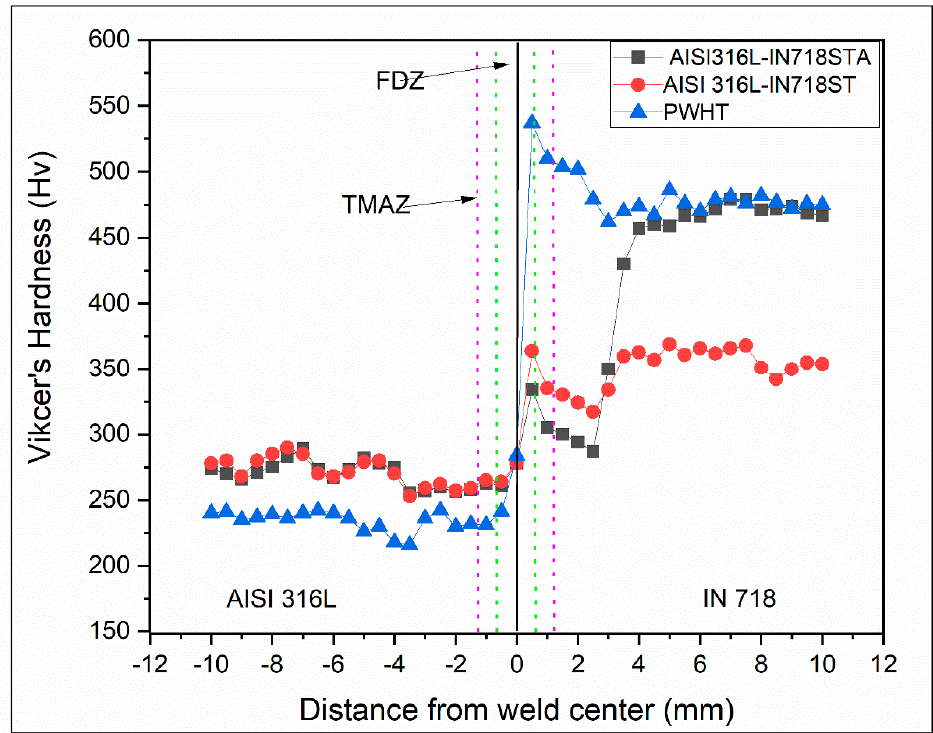
Figure 10. The microhardness distribution across the weld interface of dissimilar friction welds AISI316L-IN718 ST, AISI316L-IN718 STA, and PWHT. The tensile properties of the dissimilar weldments, including AISI 316L/IN 718 ST and AISI 316L/IN 718 STA, in both as-welded and AISI 316L/IN 718 ST PWHT conditions, were evaluated through tensile tests. The corresponding tensile curves are presented in Figure 11. From the stress vs. strain curves, the following points are noted. The AISI 316L/IN 718 ST welds showed a YS and UTS of 634 ± 9 MPa and 728 ± 7 MPa, respectively, while the % El was about 14 ± 1.5%. In contrast, the AISI 316L/IN 718 STA weldment showed YS and UTS of 602 ± 3 MPa and 697 ± 2 MPa, respectively, while the % El was about 17 ± 0.9%. As previously stated, the effect of dynamic recrystallization during the welding process in AISI 316L/IN 718 ST was higher than in AISI 316L/IN 718 STA, resulting in a drop in strength values for the latter condition. Compared to the other welds (PWHT, ST and STA), the AISI 316L/IN718 PWHT welds demonstrated greater strength (YS: 730 ± 2 MPa, UTS: 828 ± 5 MPa) but lower ductility (%El: 9 ± 1.2) (Table 5). The reason